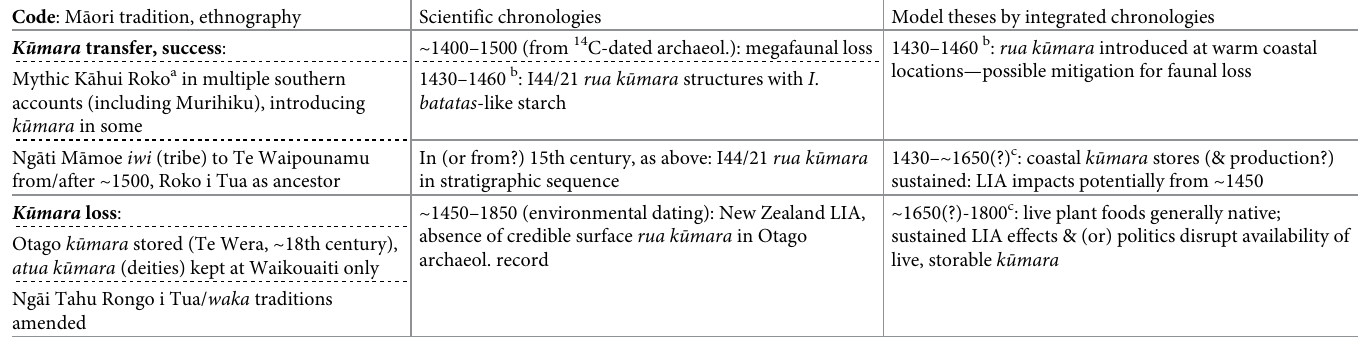
Table 2. Murihiku M ā ori and archaeological kūmara themes and chronologies correlated horizontally, after article model and S1 Text (? = interpretation tentative, all chronologies CE). Code : M ā ori tradition,